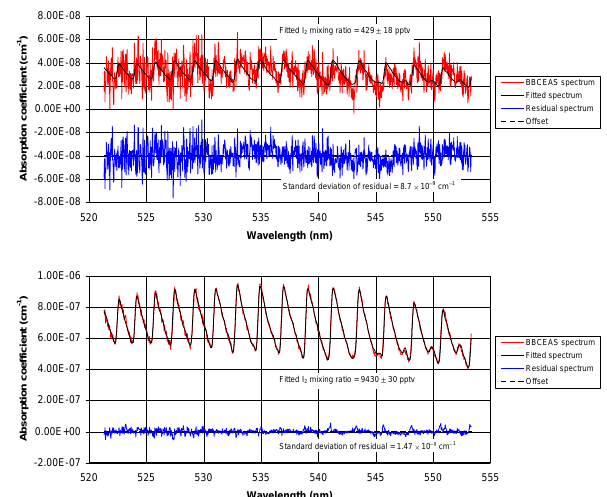
Fig. 2. Example BBCEAS spectra of I 2 emitted from Saccharina latissima (upper panel) and Laminaria digitata (lower panel). The measured BBCEAS spectrum is shown in red overlaid by the I 2 absorption cross sections scaled to produce the optimum fit to the BBCEAS spectrum (black). The residual spectrum is shown in blue (measurement minus fitted spectrum), offset below zero by 4 × 10 − 8 cm − 1 for clarity in the upper panel. The BBCEAS spectra were obtained with an integration time of 7.5s. The uncertainties quoted for the retrieved I 2 mixing ratios on this figure are the sta- tistical errors in the I 2 amounts arising from fitting the molecule’s differential structure in the BBCEAS